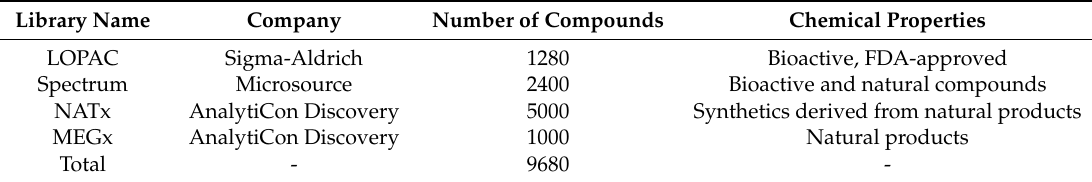
Table 1. Compound library information.